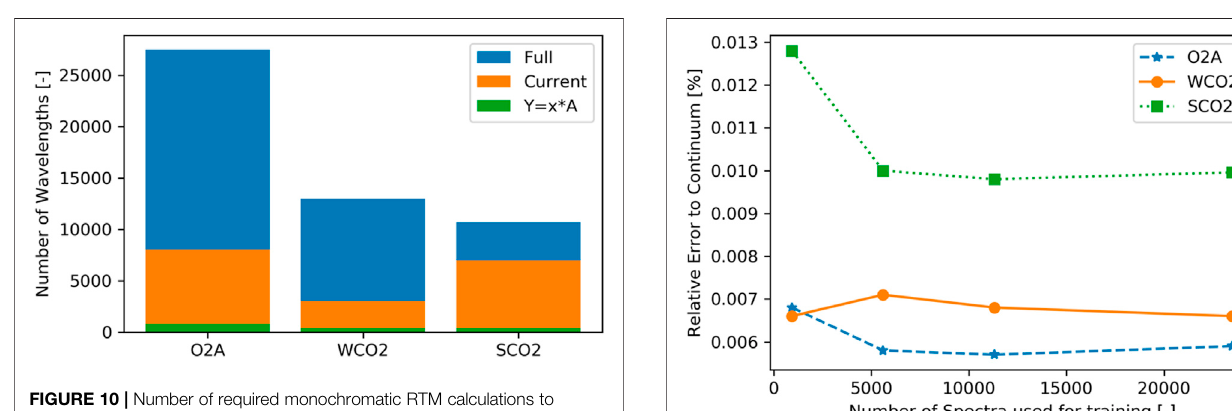
FIGURE 10 | Number of required monochromatic RTM calculations to model a complete spectrum: calculating radiances at each wavelength ( “ Full ” : blue), the current approach using linear interpolation of neighboring wavelengths ( “ Current ” : orange), and the approach proposed in this manuscript ( “ Y = x*A ” : green). The number of required RTM calculations is approximately proportional to the computational cost. Comparisons are shown for each OCO-2 instrument band.